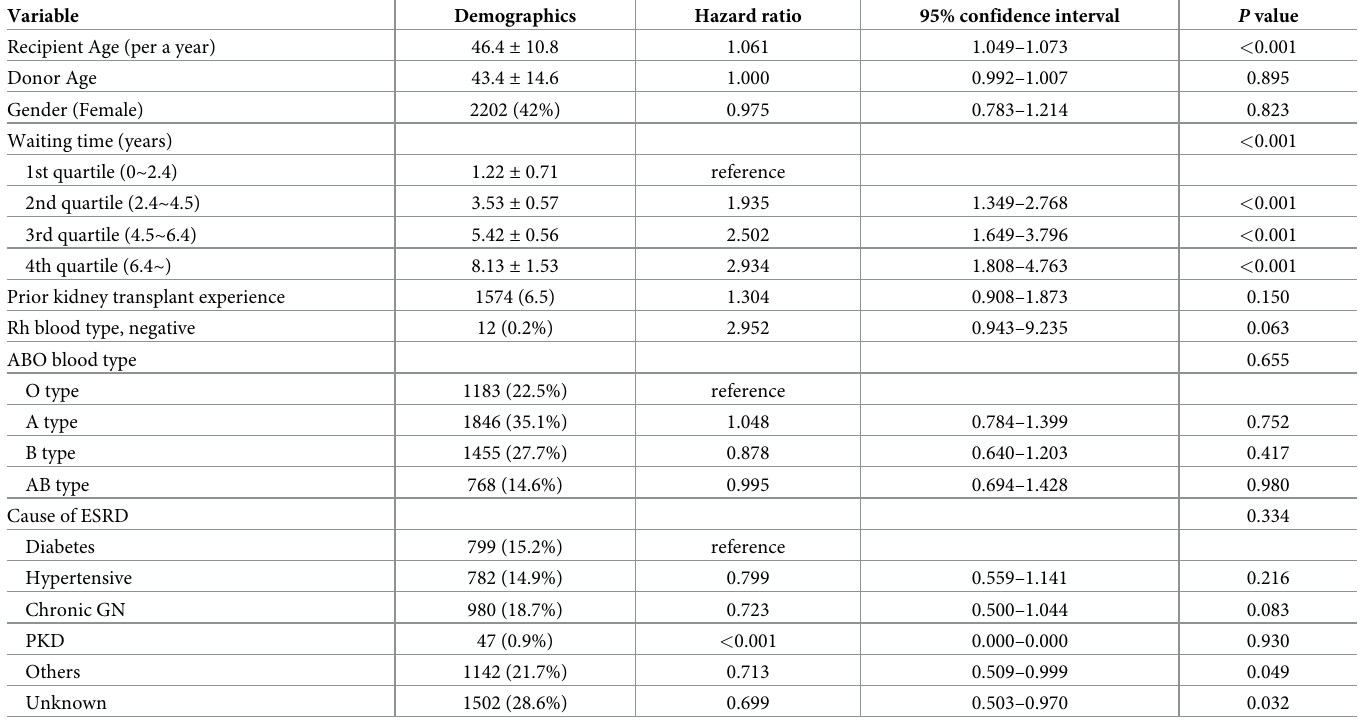
Table 2. Time-dependent cox proportional model for the overall mortality risk of deceased donor kidney transplantation.